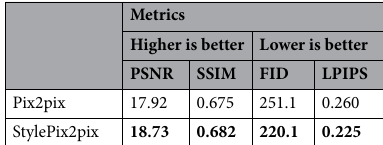
Table 1. Quantitative evaluation of generated images from edges. Significant values are in